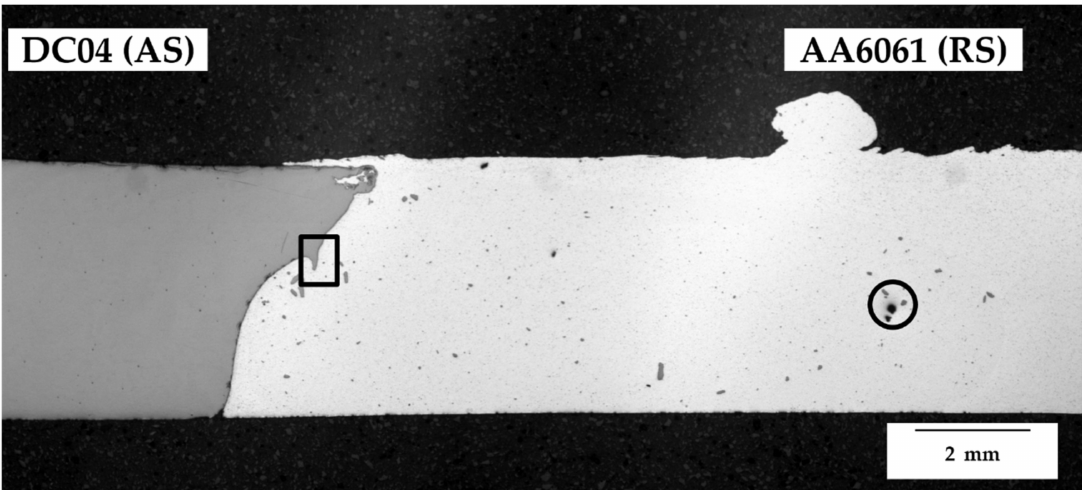
Figure 5. Cross section image of a Friction stir welding (FSW) AA6061 / DC04